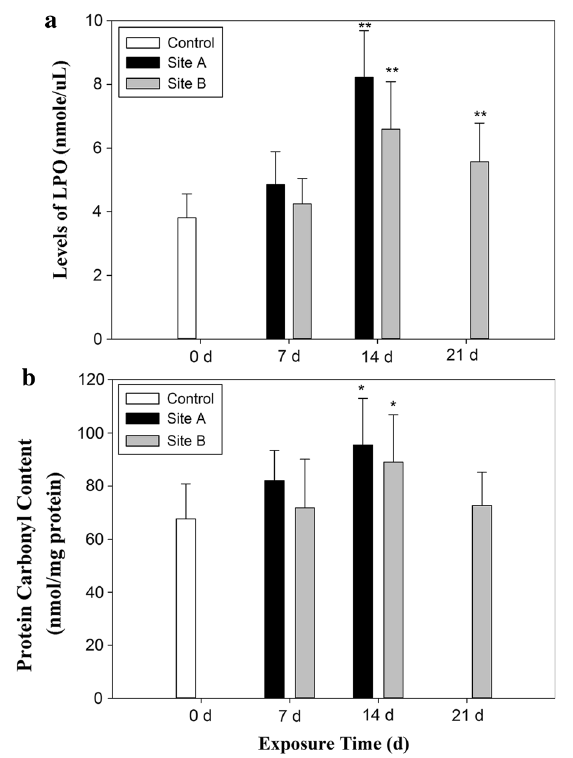
Fig. 5 Oxidative effects [the levels of LPO ( a ), PCC ( b )] in the hepatopancreas of snails ( Bellamya aeruginosa ) caged at sites A and B over the duration of the exposure experiments in Taihu Lake. Results are mean SD. Data are given from 30 individuals in each sample. ± Asterisks indicate significant difference from the control ( P < 0.05); double asterisks indicate significant difference from the control ( P <